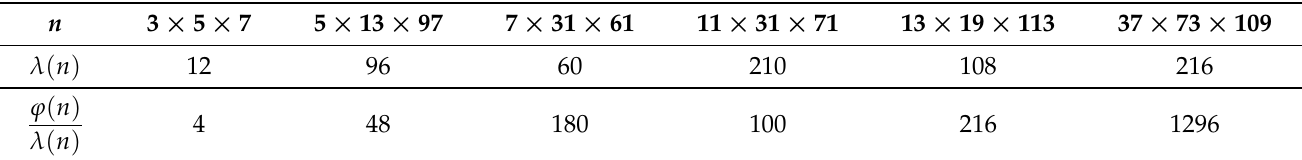
Table 2. Comparison between Carmichael and Euler functions for the product of three